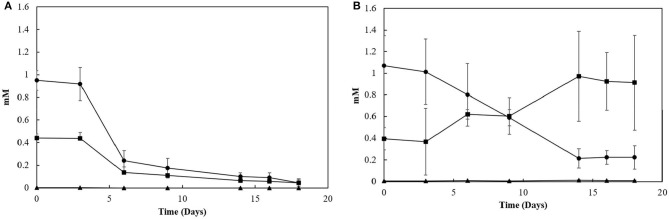
LCFA profiles in sacrificial experiments with cultures growing with (A) elemental sulfur or (B) thiosulfate as electron acceptors. Measurements of biological triplicates were averaged, and the standard deviation is shown. • oleate, ■ palmitate, ▴ myristate.